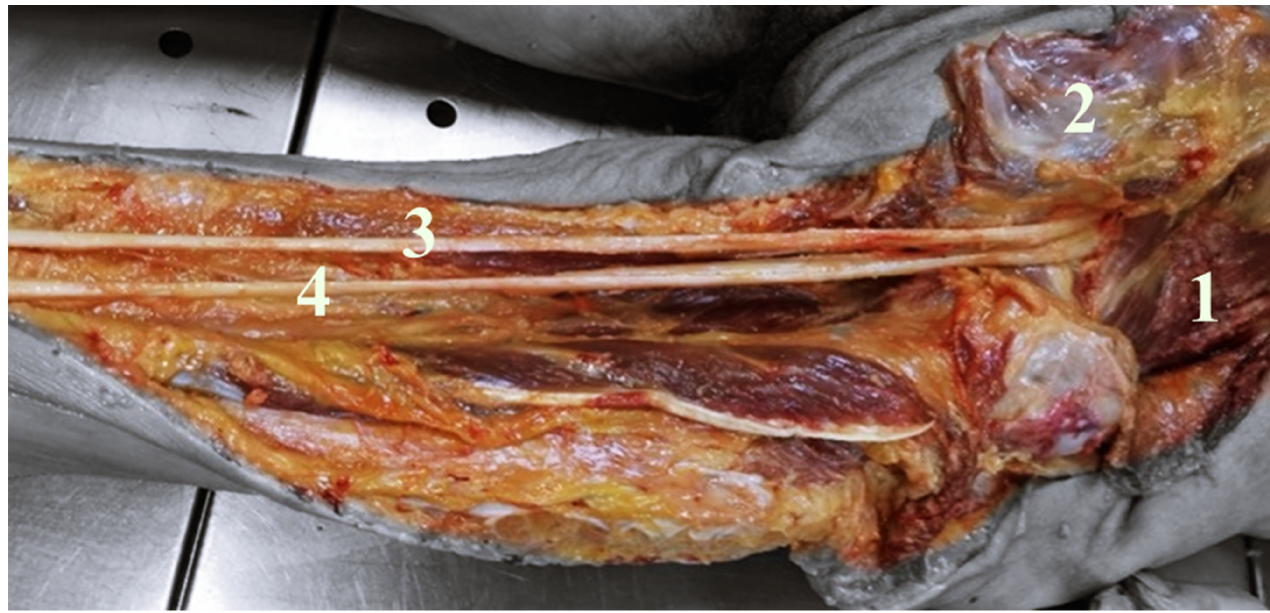
Figure 2. It shows a right deep gluteal and right posterior femoral region. After gluteal major muscle retraction (1), the PM (2) and the SN (3) are visible. The SN exit inferior to the PM, dividing into the tibial nerve (4) and the common peroneal nerve (5).